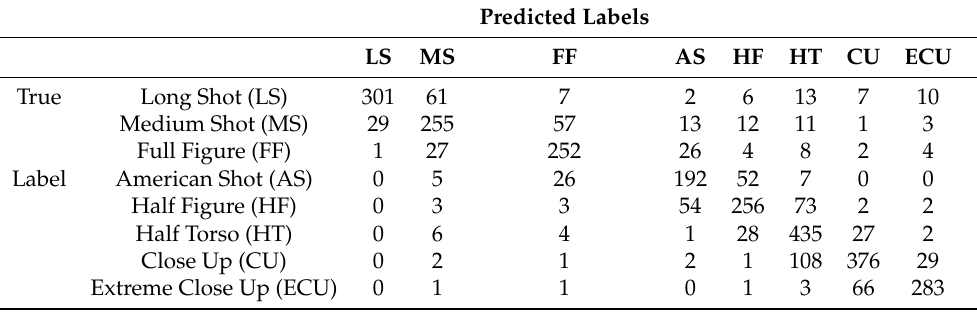
Table 2. Confusion Matrix of a VGG-16 trained on the Original Dataset.